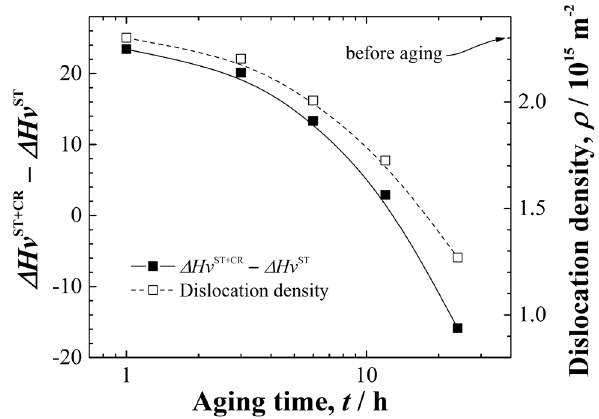
Fig. 10: Variations in Δ Hv ST + CR − Δ Hv ST for and the dislocation density of the copper matrix with aging at